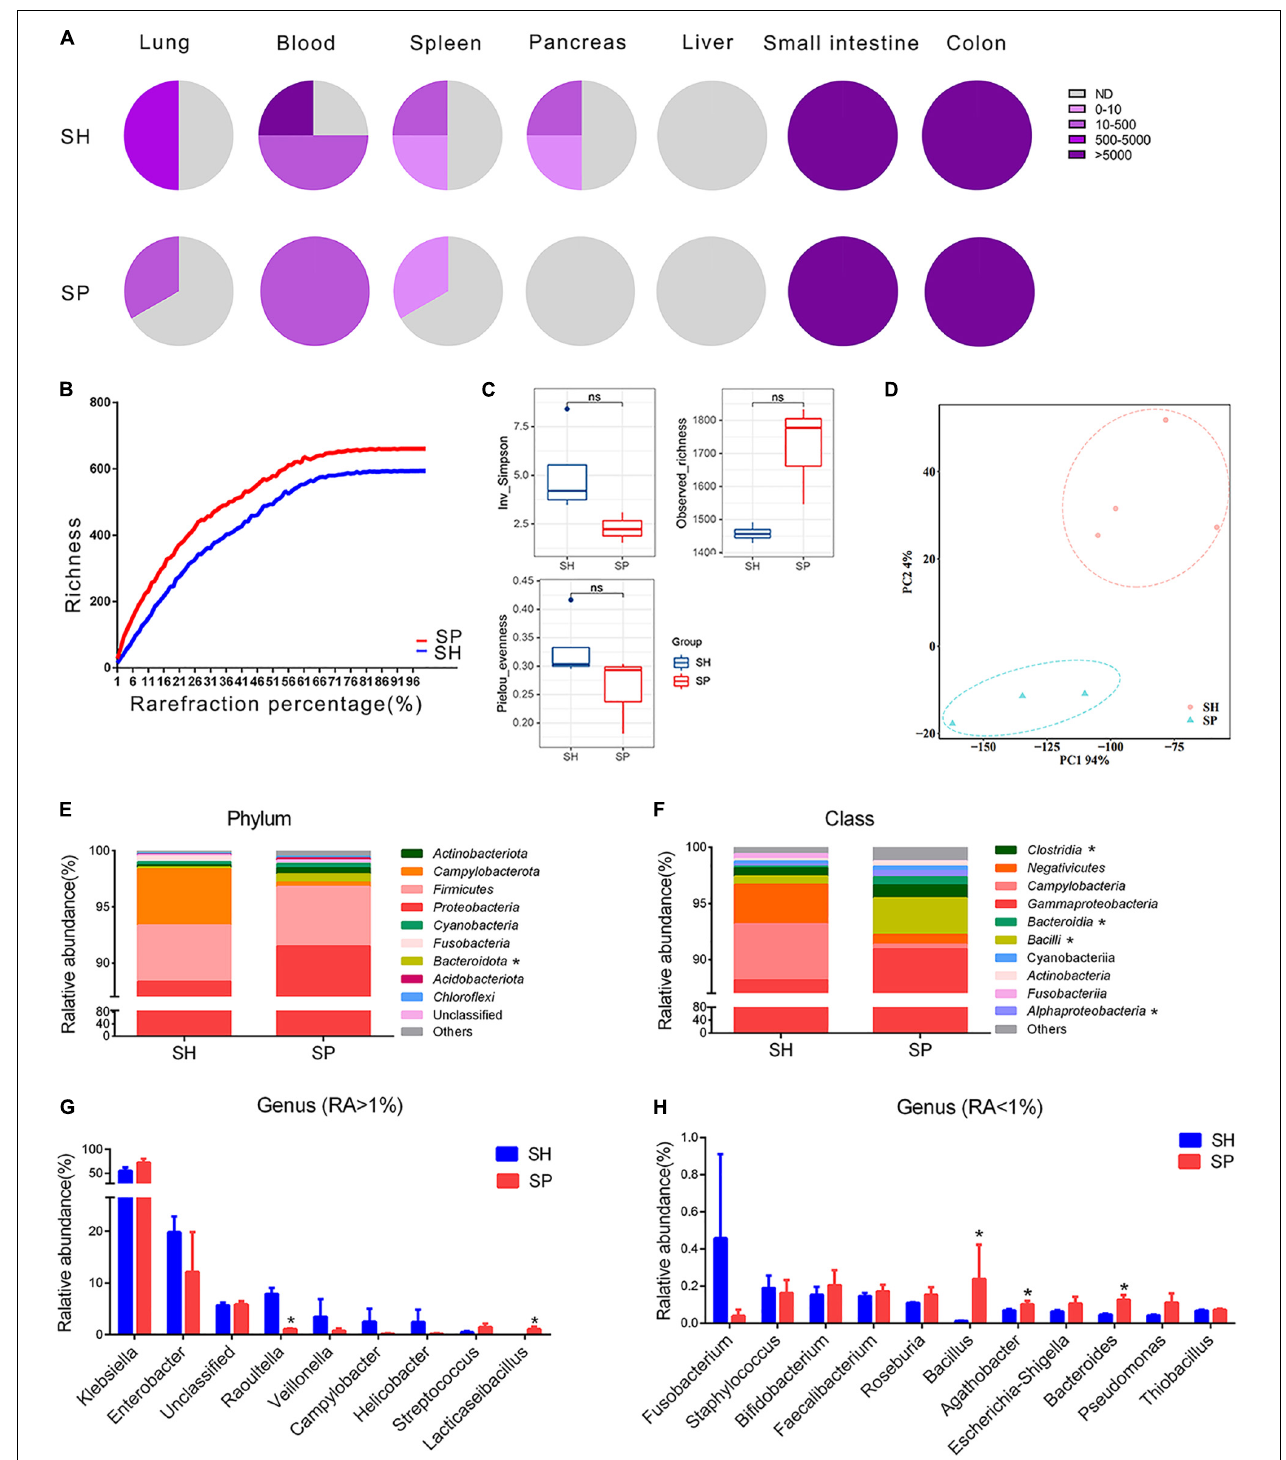
FIGURE 1 | Ectopic colonization ability of periodontitis microbiota in the extra-oral sites. (A) Fan charts of CFU numbers cultured form the extra-oral sites. (B) Rarefaction curves based on the Chao1 richness. (C,D) Alpha and beta diversity analyses in the gut microbiota. (E–H) Relative abundances of phylum (top 10), class (top 10), and genus (top 20) level in the gut microbiota. Data were calculated as means ± SEM. Unpaired Student’s t -tests were performed for panel (C) . MRPP, PERMANOVA, and ANOSIM were performed for panel (D) . The Wilcoxon rank-sum test was performed for panels (E–H) . Significant results when: * p < 0.05. SH, germ-free mice with STZ-induced T1D that orally inoculated with mixed saliva samples from the healthy ( n = 4), SP, germ-free mice with STZ-induced T1D that orally inoculated with mixed saliva samples from the periodontitis ( n = 3).